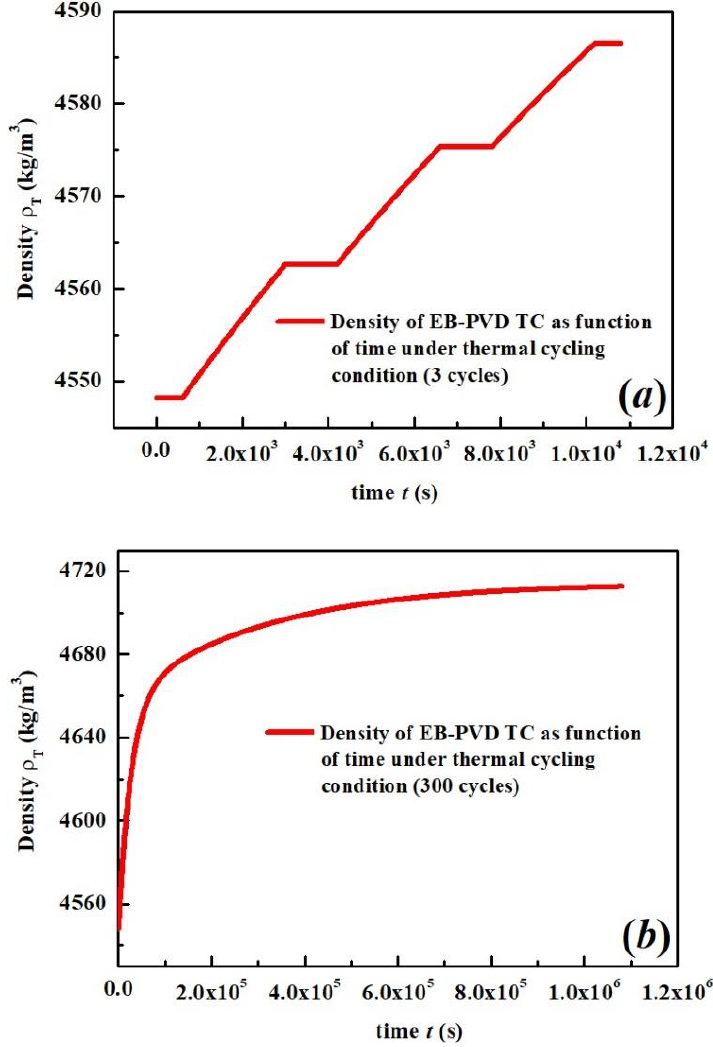
Figure 5. Density of YSZ topcoat versus time ( a ) for the first three cycles and ( b ) full 300 cycles.